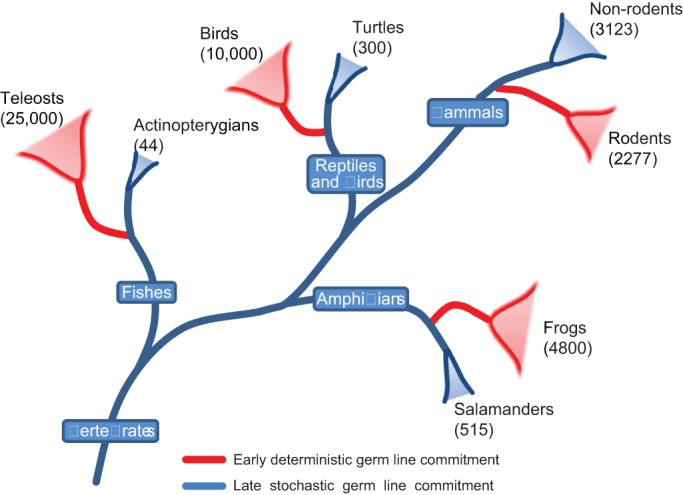
A correlation between early germ line commitment and enhanced speciation. All frogs studied contain germ plasm (Nieuwkoop and Sutasurya, 1979). All teleost embryos are likely to contain germ plasm (Herpin et al., 2007; Knaut et al., 2002). Also, all turtle species that have been studied use the inductive mode (Bachvarova et al., 2009a,b). The situation for other reptiles is more ambiguous. Among mammals, the rodent lineage accounts for ∼40% of all species. Numbers in brackets indicate the number of species.